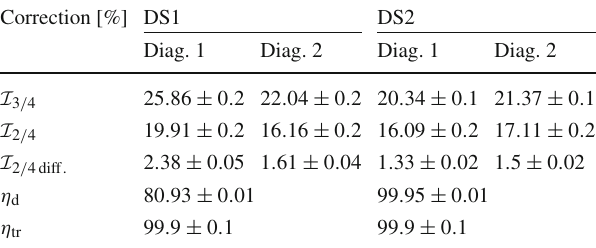
Table 2 Corrections to the differential and total elastic rate for the Table 1 The t -dependent analysis uncertainties and corrections to the different datasets and diagonals. The “uncorrelated” inefficiency cor- differential elastic rate and to the optical point for both diagonals rection ( I 3 / 4 ) is θ ∗ y dependent, in the table its effect on the elastic rate | t | | t | min max is Alignment uncertainty ± 1 . 3%